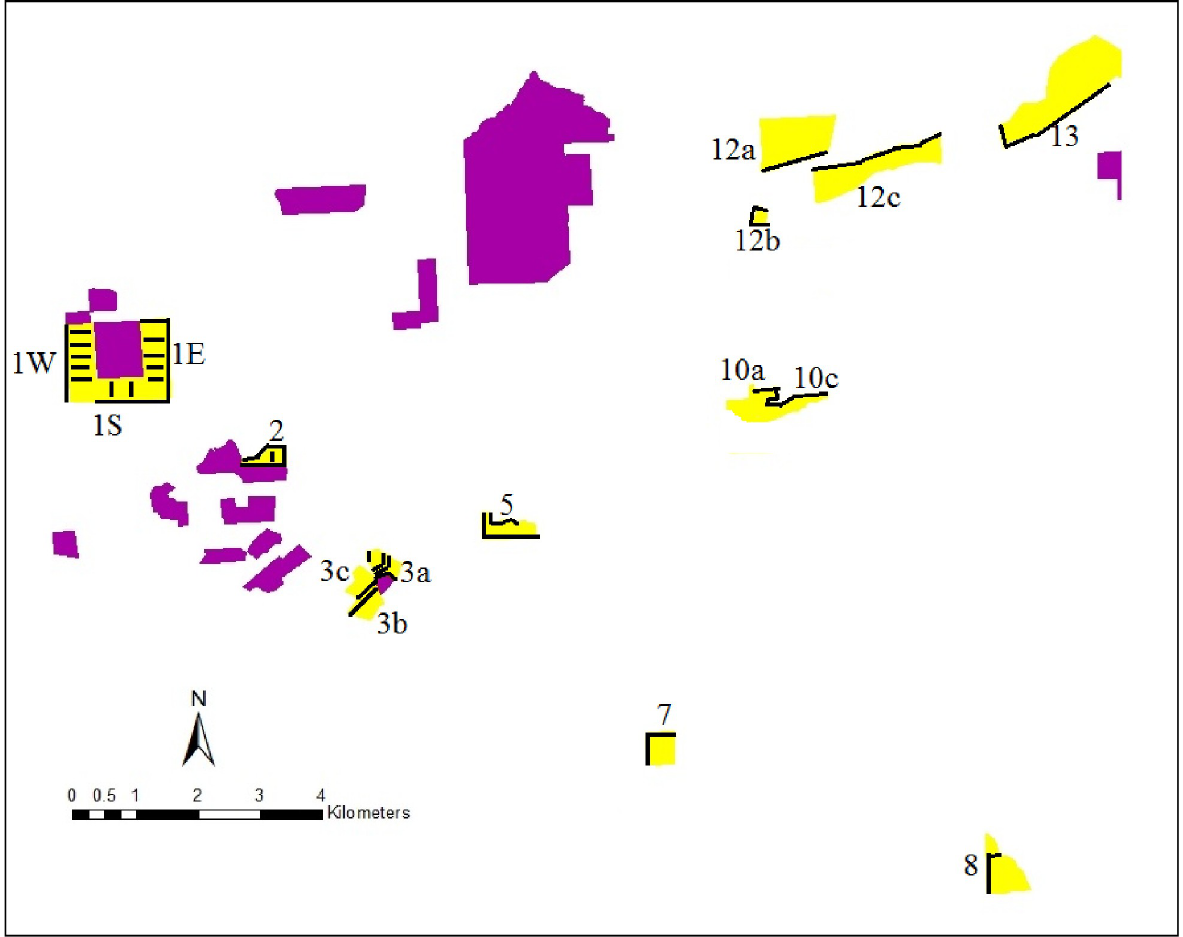
Fig 1. Distribution of commercial GE seed fields (pink) and conventional seed fields (yellow) that we sampled for GE gene presence in 2013 near Touchet Valley, Walla Walla County, Washington. Black lines represent transects and edges